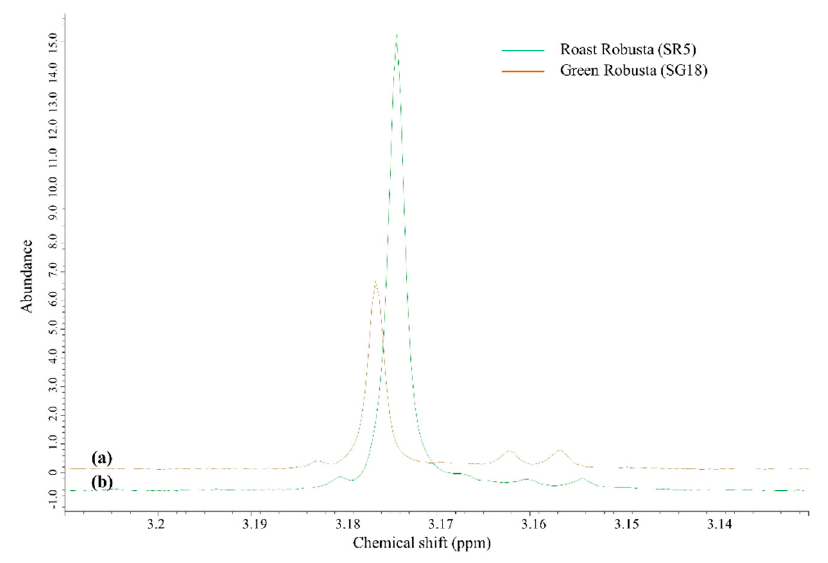
Figure 3. The expanded region of the 16-OMC signal for roast Robusta ( a ) and green Robusta ( b ).